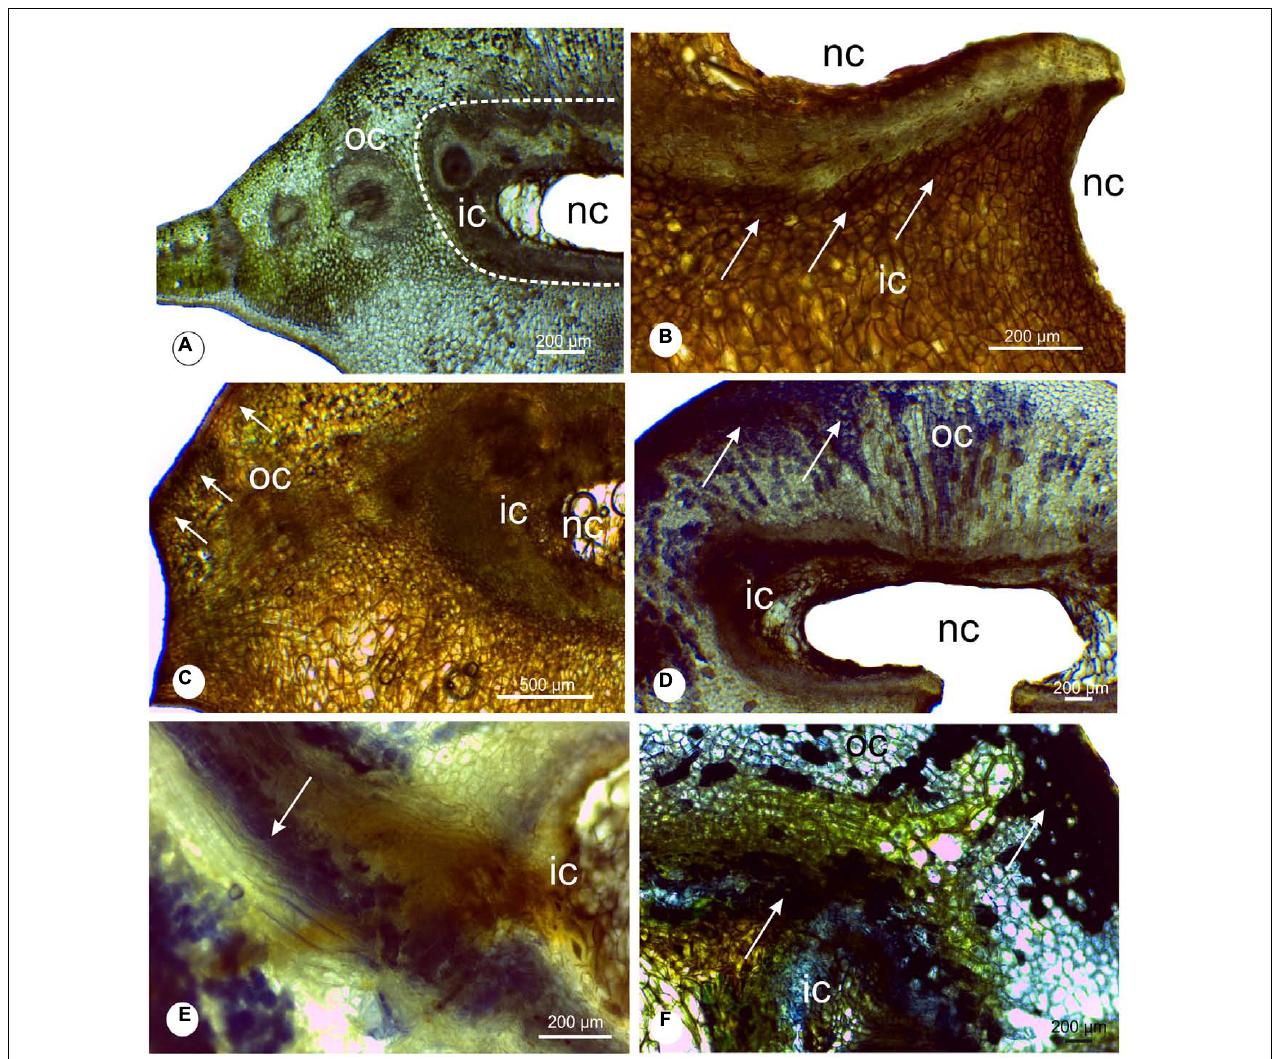
FIGURE 5 | Histochemical analysis of leaflet galls induced by Bystracoccus mataybae (Eriococcidae) on Matayba guianensis (Sapindaceae). (A) Transverse section of a gall with no staining, evidencing the distribution of the chlorophyllous tissue. (B) Histochemical detection of oxygen reactive species (ROS) with DAB (3,3 (cid:48) -diaminobenzidine). The positive reaction is evidenced by the brown spots. (C) Histochemical detection of ROS with DAB in the outer and inner cortex of galls. (D) Proanthocyanidins were detected with DMACA ( p- dimethylaminocinnamaldehyde) at the chlorophyllous tissue. (E) Detail of proanthocyanidins in cells around the nymphal chamber, and in lignified cells. (F) Phenolic compounds detected with 2% ferrous sulfate in 10% formalin in gall outer cortical tissues, continuous to the chlorophyllous tissue. ic, inner cortex; nc, nymphal chamber; oc, outer